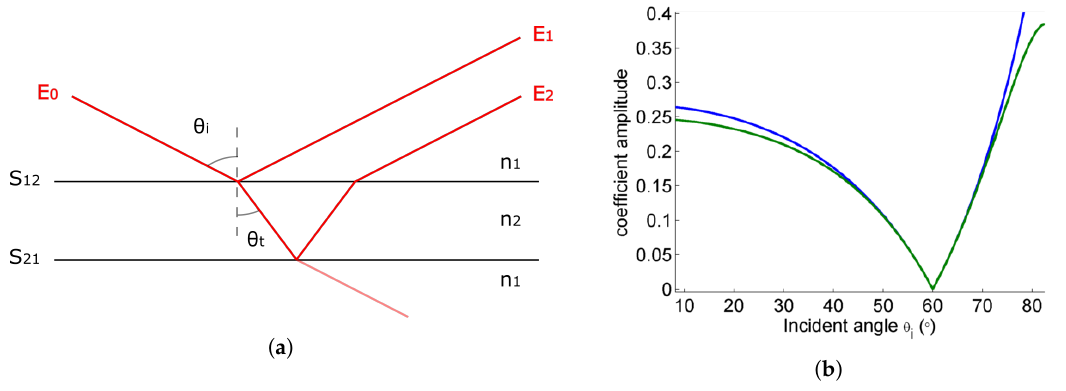
Figure 2. ( a ) Sketch of the film sample and the terahertz (THz) beam reflected or transmitted at the interfaces S 12 and S 21 . ( b ) Reflection coefficients behavior for a THz beam reflected off the front ( S 12 , blue) and back ( S 21 , green) interfaces for arbitrary material